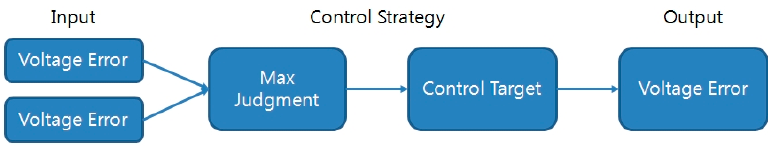
Figure 6. Decision-making principles.